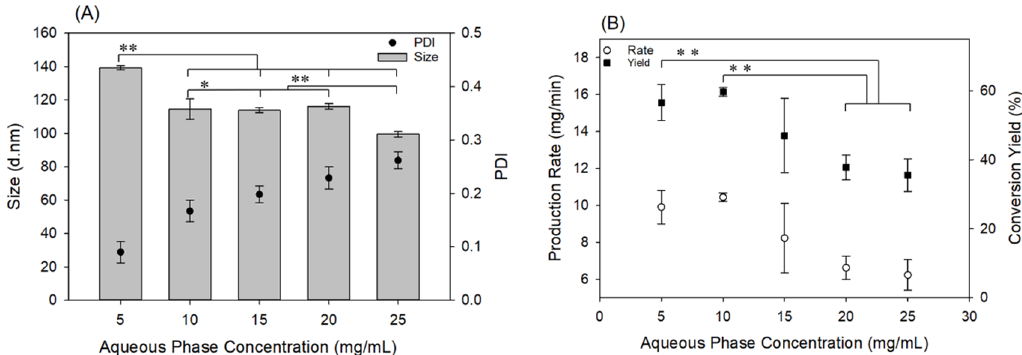
Figure 6. E ff ect of PVA concentration on aqueous phase on ( A ) NP size and PDI and ( B ) production rate and conversion yield. For this study, the flowrate of the PVA solution (aqueous stream) was 25 mL / min, and the concentration and flowrate of the PLGA solution (organic stream) was 5 mg / mL and 3.5 mL / min, respectively. In ( A ): * No statistically significant di ff erence between the size of NPs prepared with the aqueous phase concentration at 10, 15, or 20 mg / mL ( p > 0.05). ** Statistically significant di ff erence in